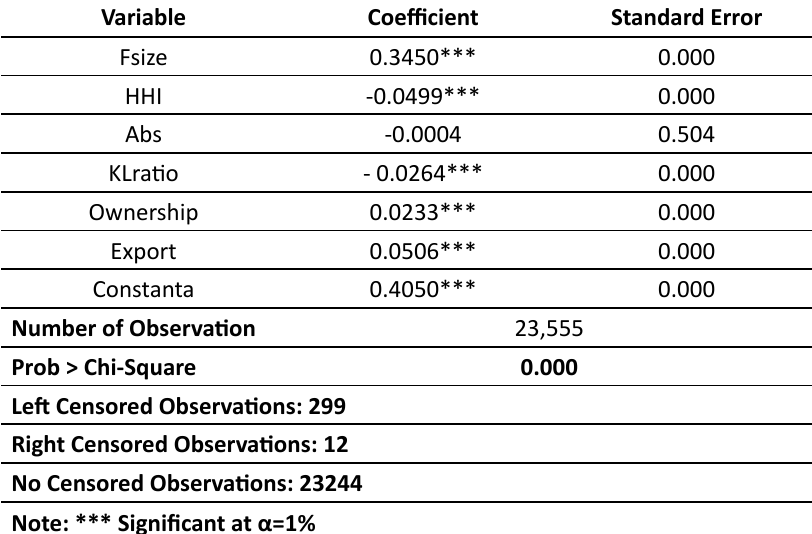
Table 1: The Tobit Regression of the Latent